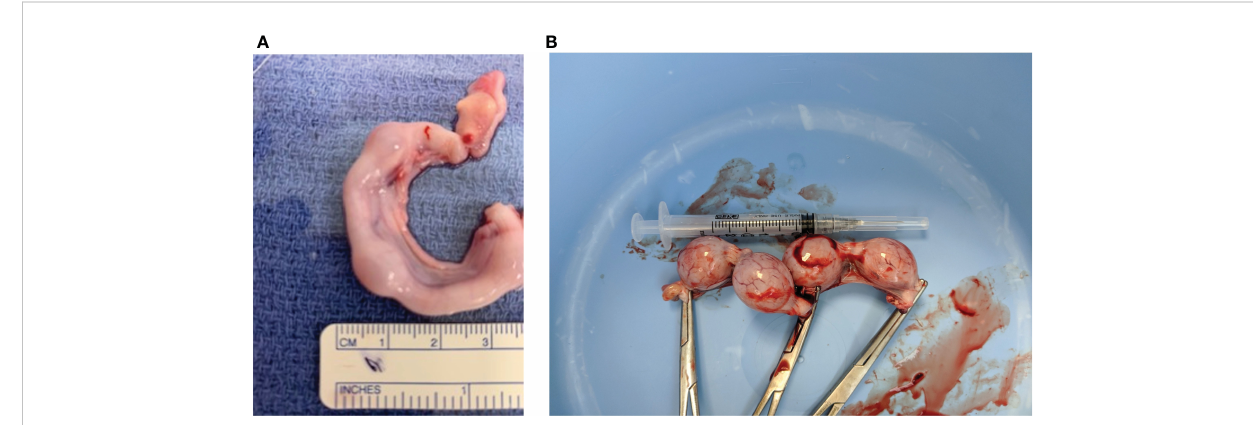
FIGURE 1 Representative images of two early stage feline embryo collections. (A) Right uterine horn indicating embryos less than ~3 weeks of gestation. (B) Four fetuses (~25 mm) collected from of a ~21 day pregnant feline. (Dr. Shauna O ” Meara, BVSc, “ Stage of Cat Pregnancy ”